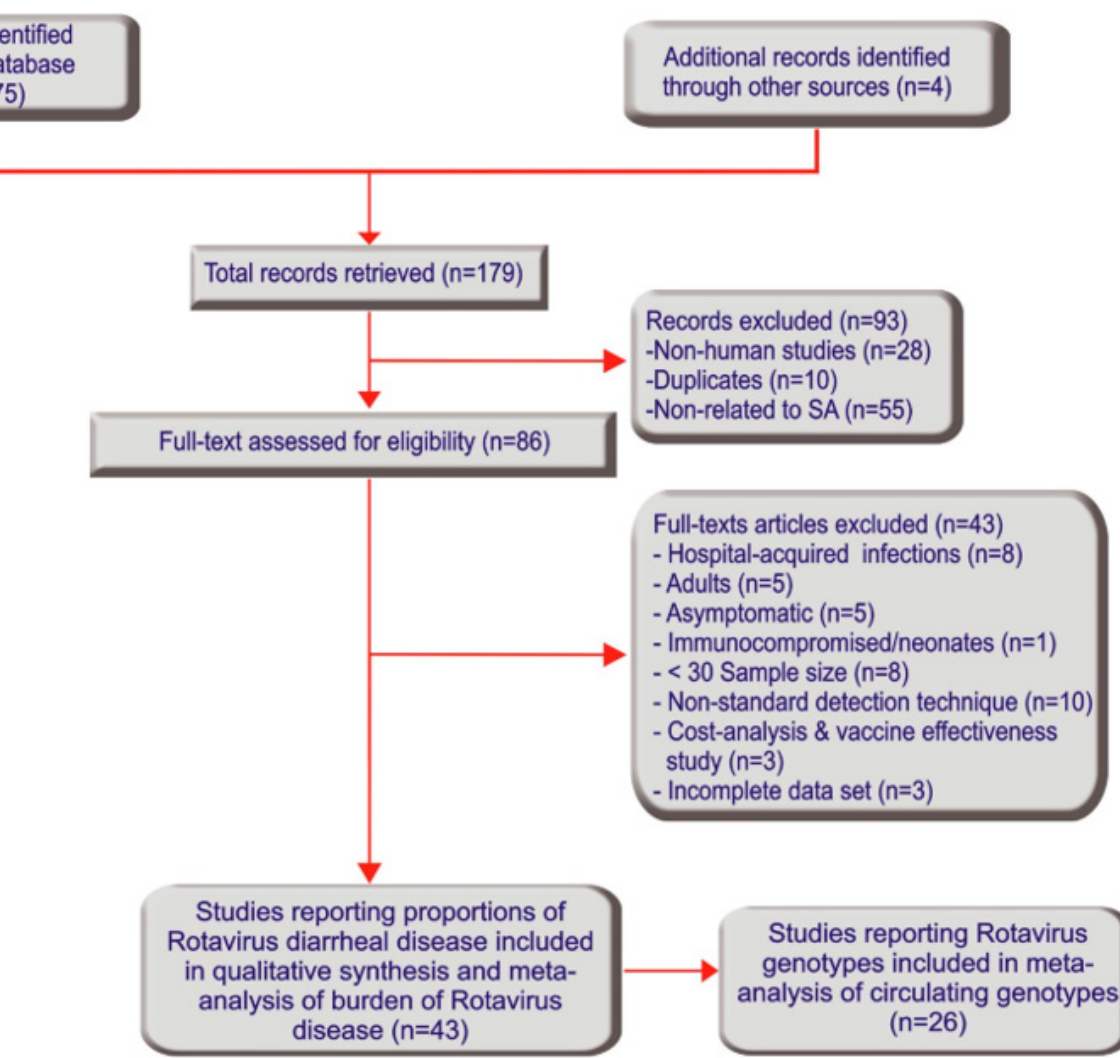
Figure 1. Study search and retrieval processes (Preferred Reporting Items for Systematic Reviews and Meta-Analyses flowchart). Table 1. Descriptive characteristics of included studies in South Africa.